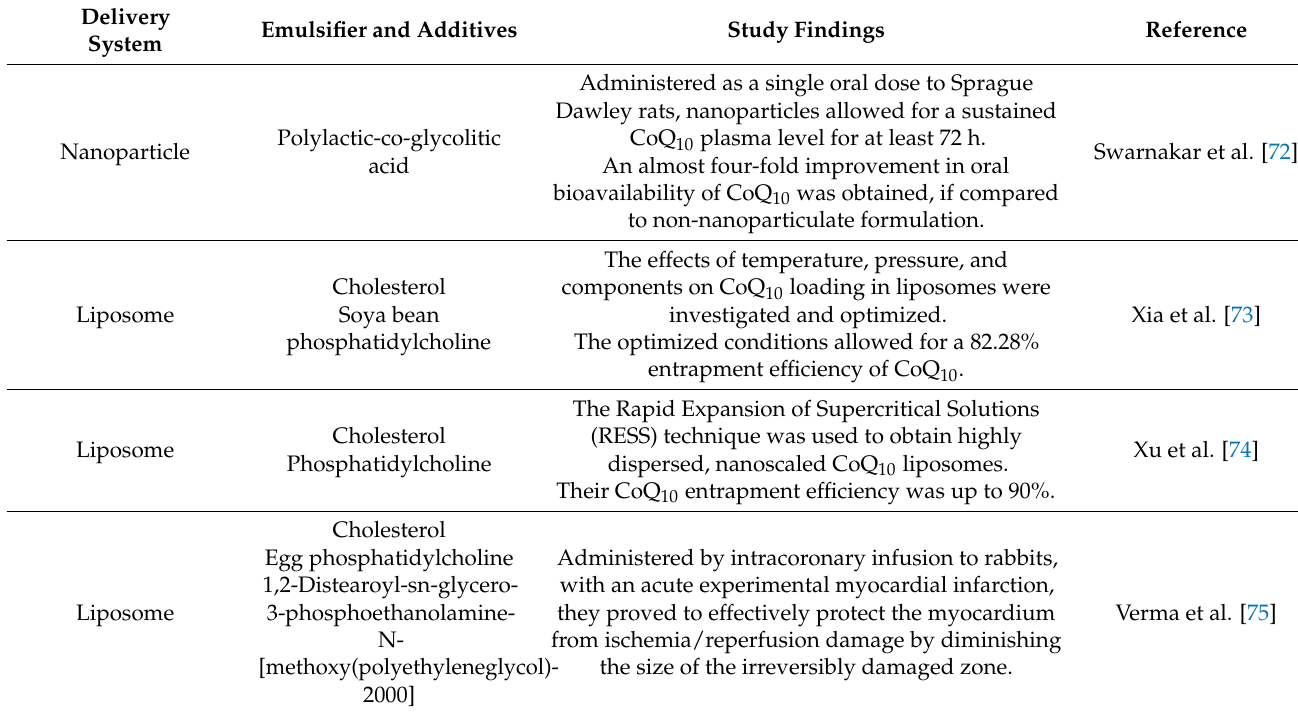
Table 1. Summary of studies investigating CoQ 10 encapsulation into different delivery